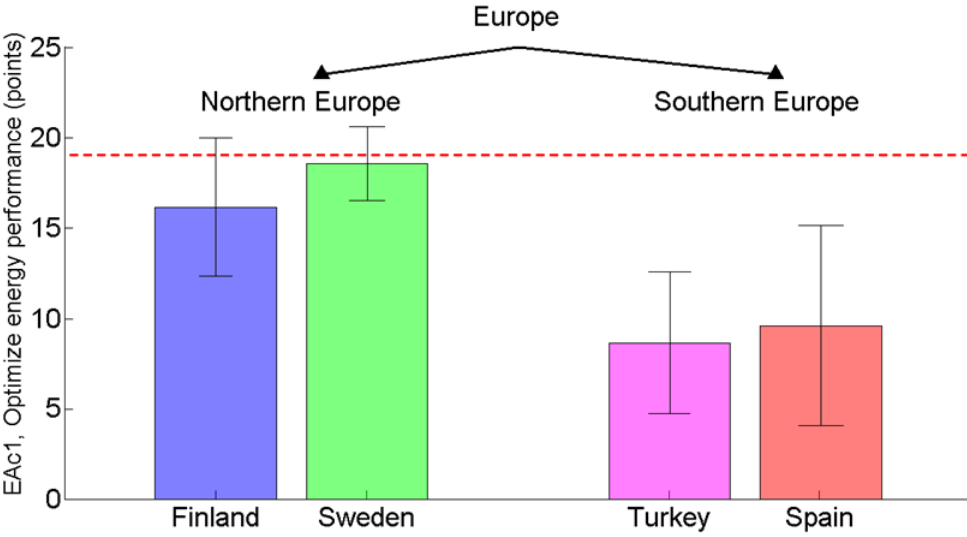
Figure 1. The EAc1 Optimize Energy Performance: Northern European countries vs. southern European countries. A red dashed line refers to the maximum possible points.